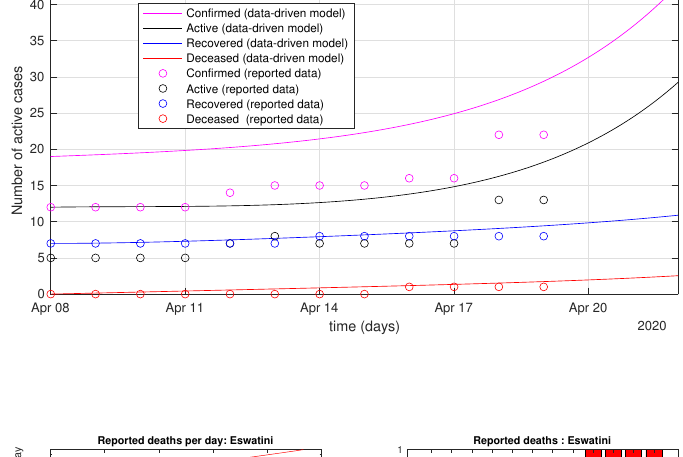
Confirmed (data-driven model) Active (data-driven model) Recovered (data-driven model)